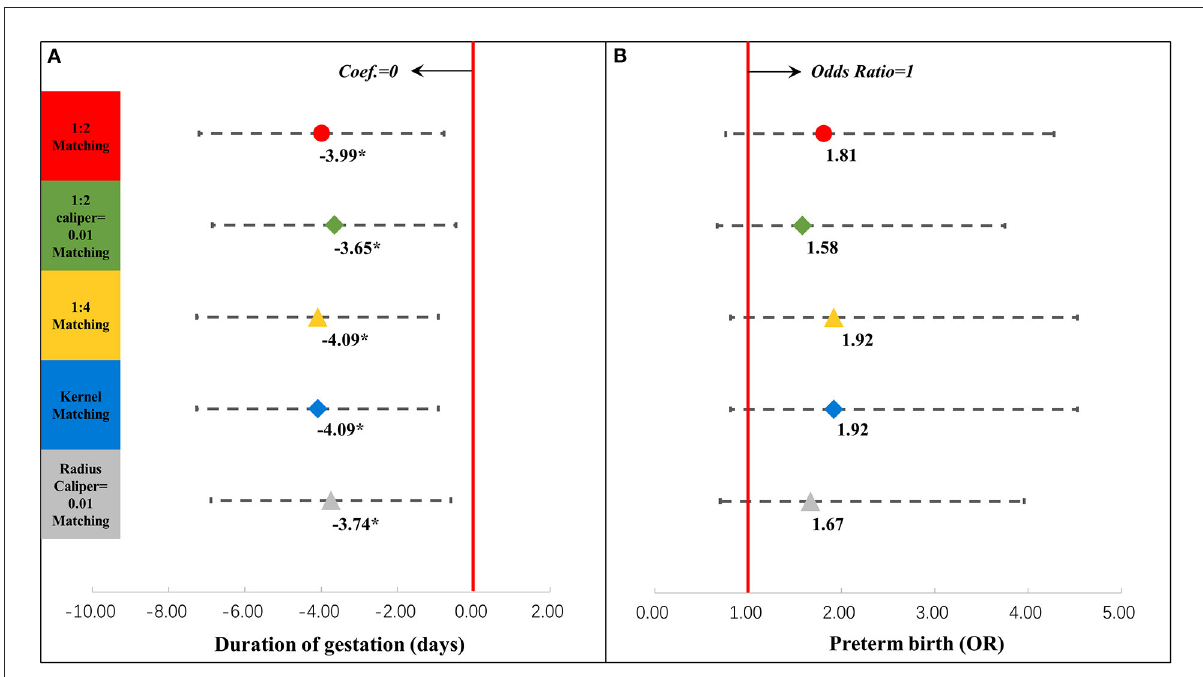
FIGURE4 Results of regression analysis of the duration of gestation (A) and preterm birth (B) after propensity score matching. * P < 0.05, ** P < 0.01, *** P < 0.001. The results of different propensity score matching analyses are reported too. Dots and lines represent means and 95% confidence intervals for Coef. or ORs estimated from generalized linear mixed regression analyses. Maternal, family, and infant characteristics were also included in the regression analyses but are not reported. Details are provided in Supplementary Table 5. Coef, coefficient; OR, odds